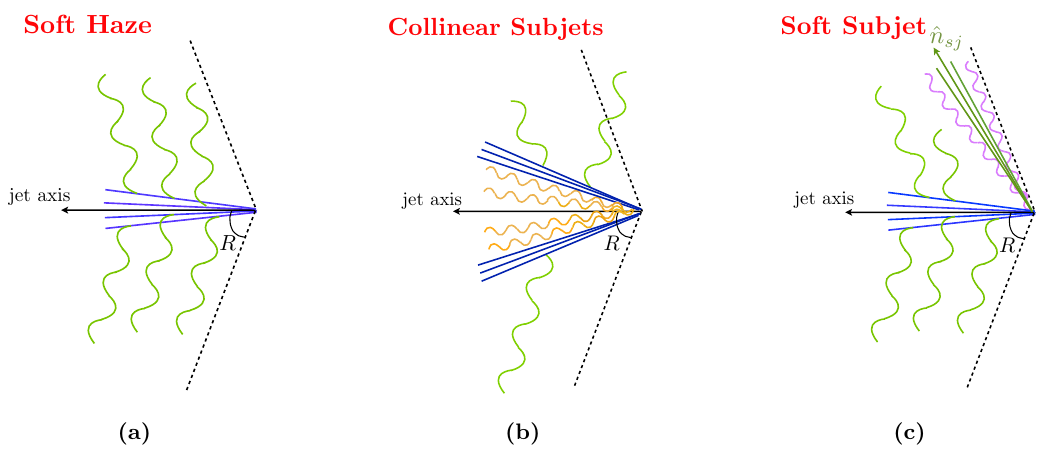
Figure 4. Regions of interest for studying the two-prong substructure of a jet. (a) Soft haze region in which no subjets are resolved. (b) Collinear subjets with comparable energy and a small opening angle. (c) Soft subjet carrying a small fraction of the total energy, and at a wide angle from the hard